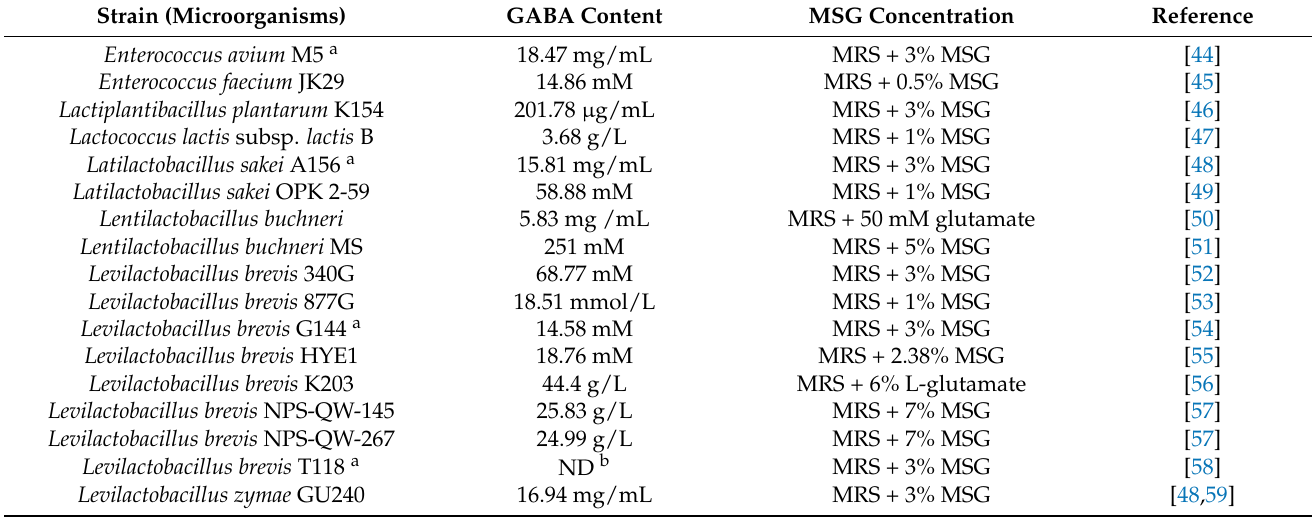
Table 2. GABA production yields by LAB isolated from kimchi or